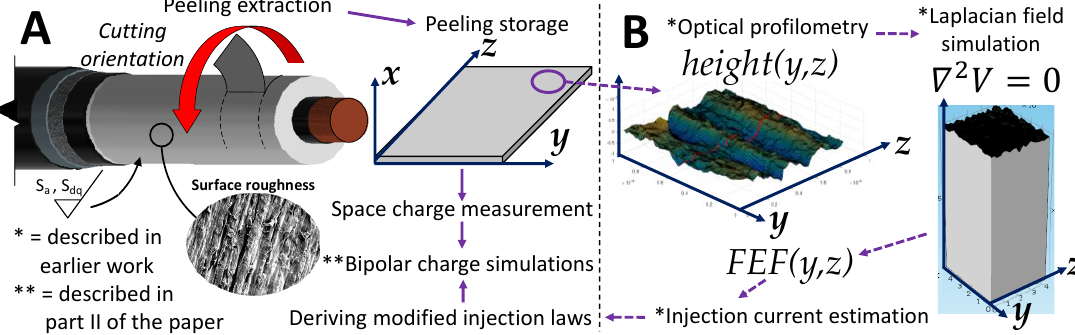
Figure 2. Sample preparation, storage and space charge measurements performed in the present study ( A , left). Previously performed work ( B , right) encompassing profilometry, field simulation and injection current estimation [5–7], allowing for the derivation of modified injection laws in the present study. A Cartesian coordinate system (x, y, z) is adopted, with estimated current density oriented here in the x -direction.